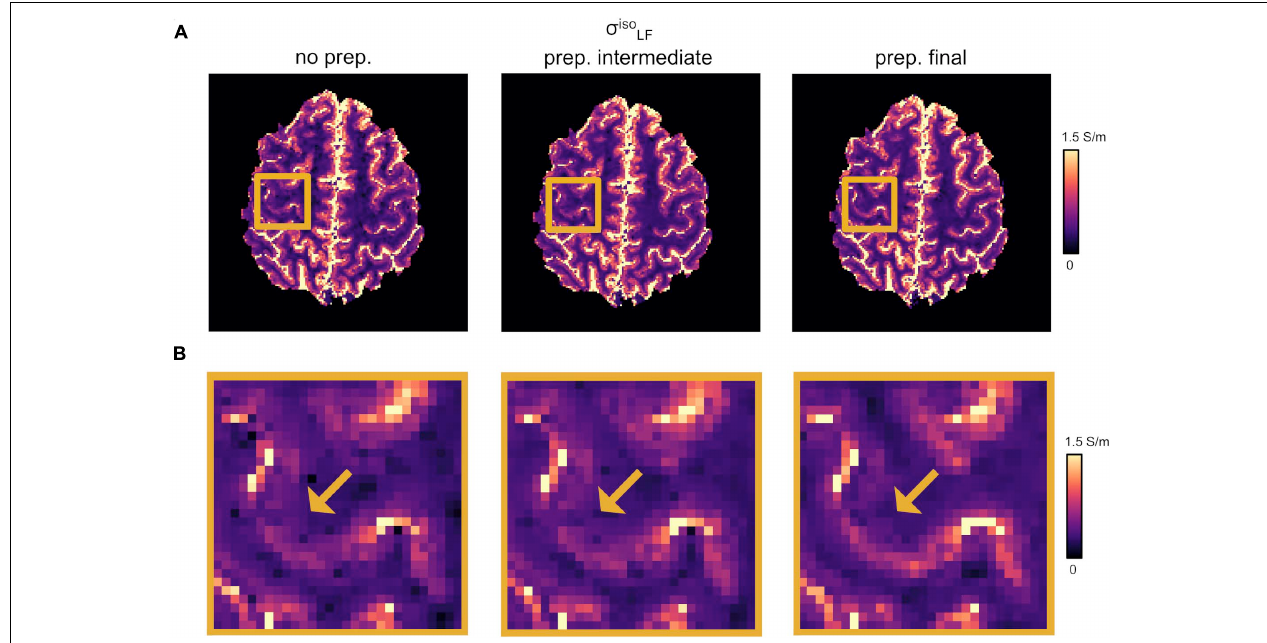
FIGURE 2 | Effect of DTI pre-processing. (A) Changes in σ iso LF as a function of the different DTI pre-processing steps. (Left) No pre-processing applied (“ no prep.” ). (Center) Intermediate pre-processing applied (“ prep. intermediate ”); i.e., denoising plus bias field correction). (Right) Full pre-processing applied (“ prep. final ”); i.e., “ prep. intermediate ” plus distortion correction and linear registration onto σ HF . (B) Magnified region from panel (A) . Yellow arrows point to WM/GM boundaries.